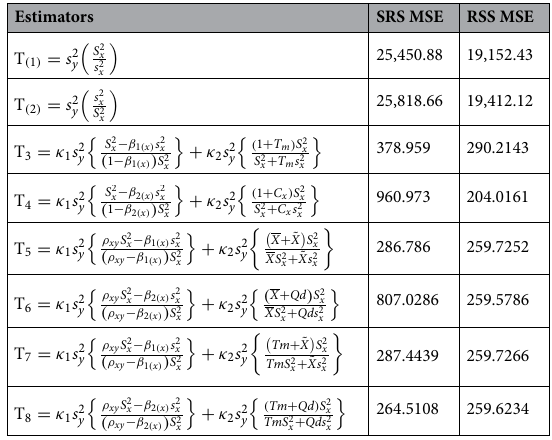
Table 2. Mean square error of different estimators.